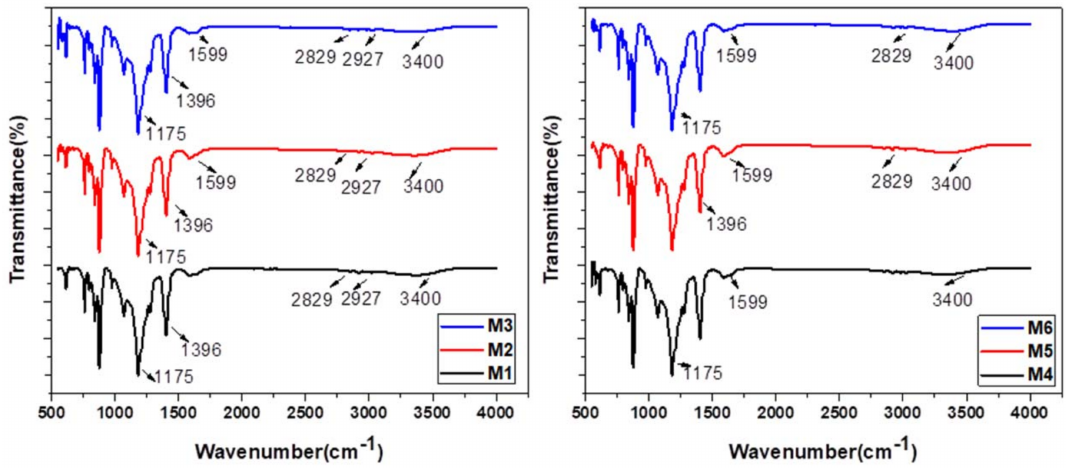
Figure 7. FTIR analysis of aminated graphene oxide (AGO)-based PVDF